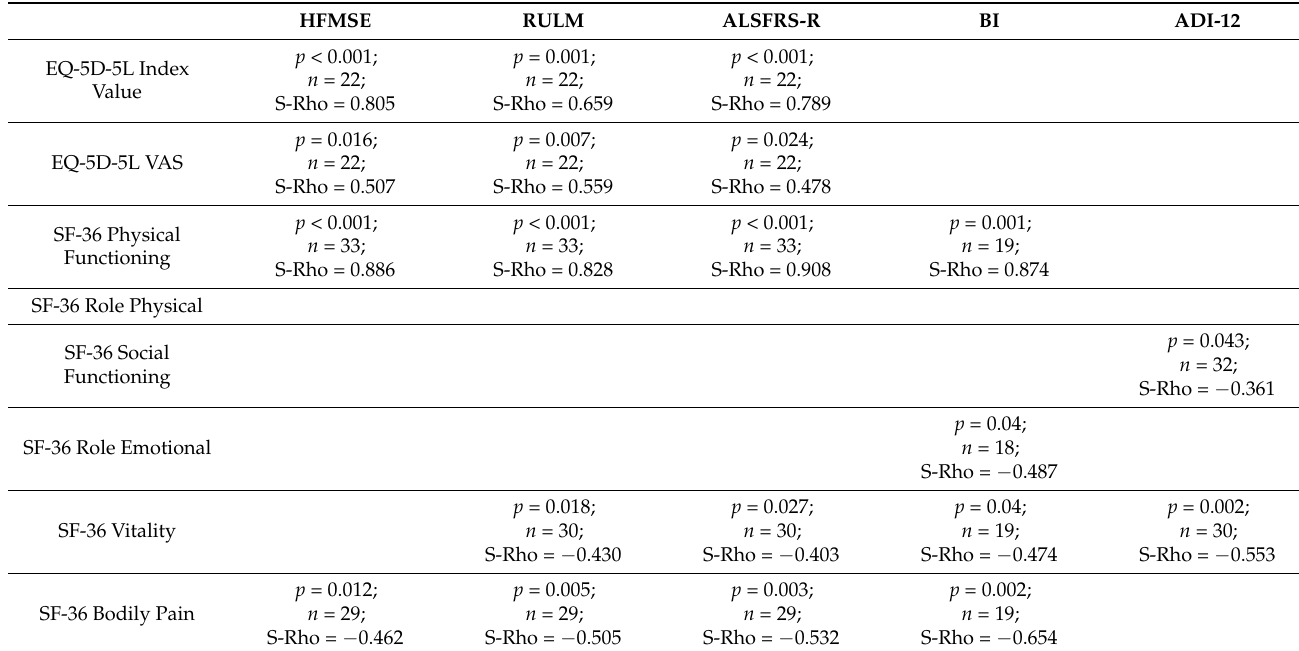
Table A1. Correlation analyses of HRQoL: Motor/ADL scores correlated positively with EQ-5D-5L and Physical Functioning, while Bodily Pain, Vitality, and Role Emotional were negatively correlated with them. The ADI-12 correlated negatively with Vitality, Mental Health, General Health, and Social Functioning. Abbreviations: ADL = activities of daily living; ADI-12 = ALS-Depression Inventory-12; ALSFRS-R = Amyotrophic Lateral Sclerosis Functional Rating Scale Revised; BI = Barthel Index; EQ-5D-5L = Euro QoL Five Dimension Five Level Scale; HFMSE = Hammersmith Functional